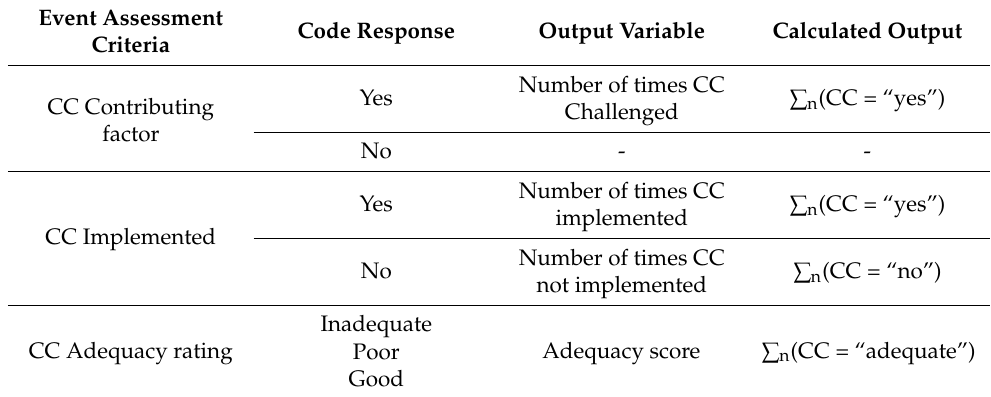
Table 1. CC data